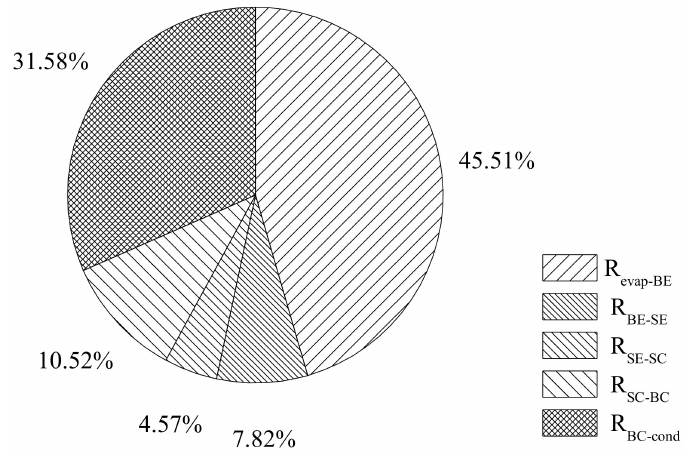
Figure 3. Thermal resistance distribution (%) for traditional PHP thermal module. The original raw data is taken from [11], and replots using a different kind of schematic for